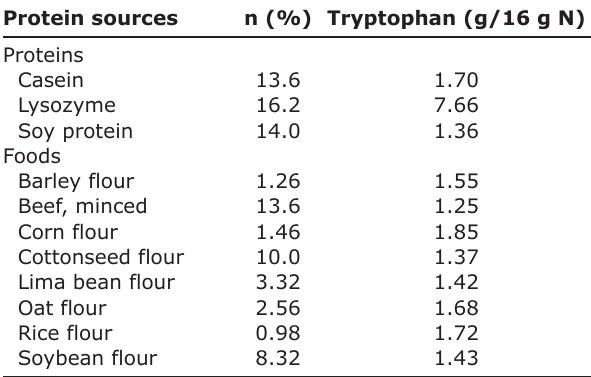
Table-1: Tryptophan content of proteins and flours.